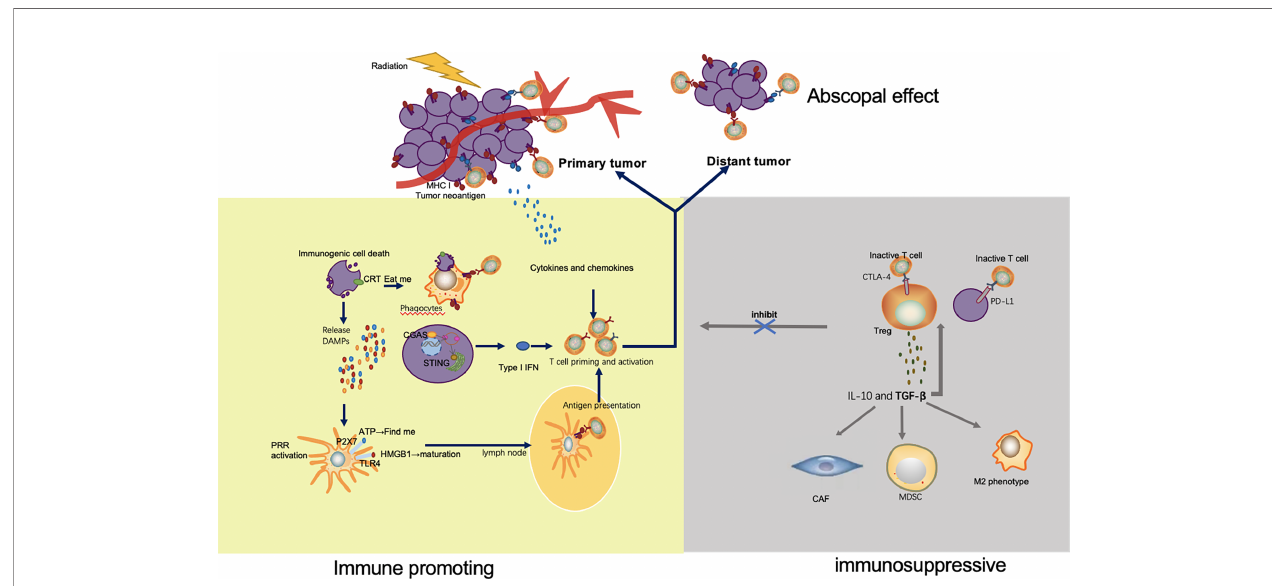
FIGURE 1 | Mechanisms by which radiation enhances and inhibits immune response. Irradiation of tumor leads to immunogenic cell death and release of tumor neoantigens. Multiple DAMPs secreted from apoptotic tumor cells facilitate the uptake and presentation of neoantigens. Released ATP and exposure of CRT send the ‘ fi nd me ’ and ‘ eat me ’ signal to APC and phagocyte respectively. HMGB1 promotes maturation of APC through binding with TLR4. As a result, APC migrates to lymph nodes and presents neoantigens to T cells mediated by MHC pathway. In addition to antigen presentation, type I IFN via cGAS-STING pathway and a variety of other cytokines and chemokines also take part in T cell priming and activation. The activated T cells, especially the CD8 + T cells proliferate, home to tumor, and exert their killing effect. Apart from the irradiated tumor site, effector T cells also migrate to distant tumors and drive abscopal effect. However, immune escape appears after radiation, which limits the ef fi cacy of radiation. Upregulation of immune checkpoints, such as CTLA-4 on Tregs and PD-L1 on tumor cells, inhibits the activation and function of T cells. TGF b secreted by Tregs is capable to signi fi cantly increase the number of immunosuppressive cells in the TME, including Treg, CAF, MDSC and M2 phenotype